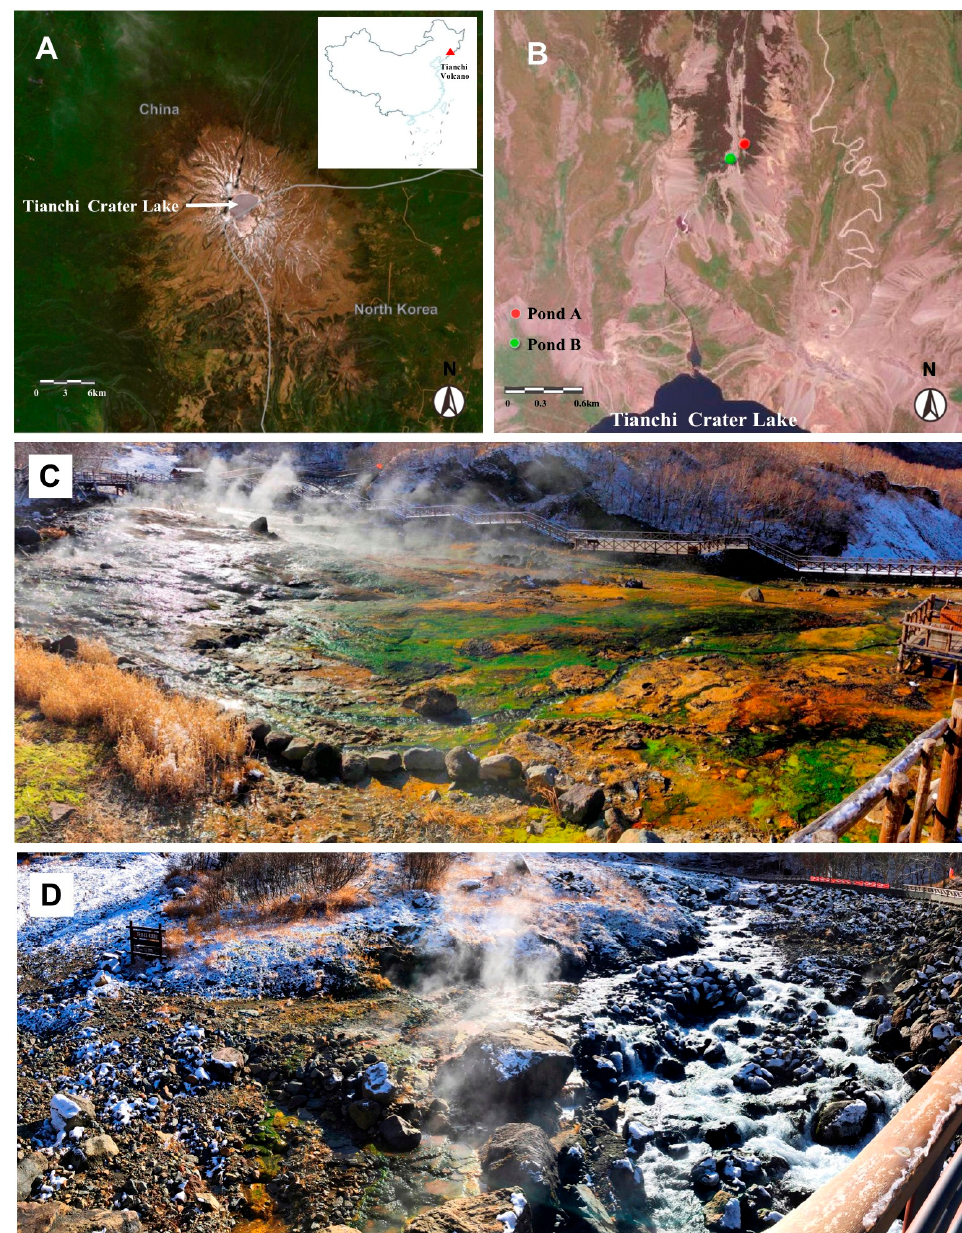
Figure 1. ( A ) Location of Tianchi Volcano in China and vertical view; ( B ) detailed location of the sampling area on the northern side of Tianchi Volcanic cone; ( C ) the main pond system: Pond A; ( D ) the smaller spring area: Pond B. The maps were generated from ArcGIS Online (https://maps. arcgis.com/index.html, accessed on 31 March